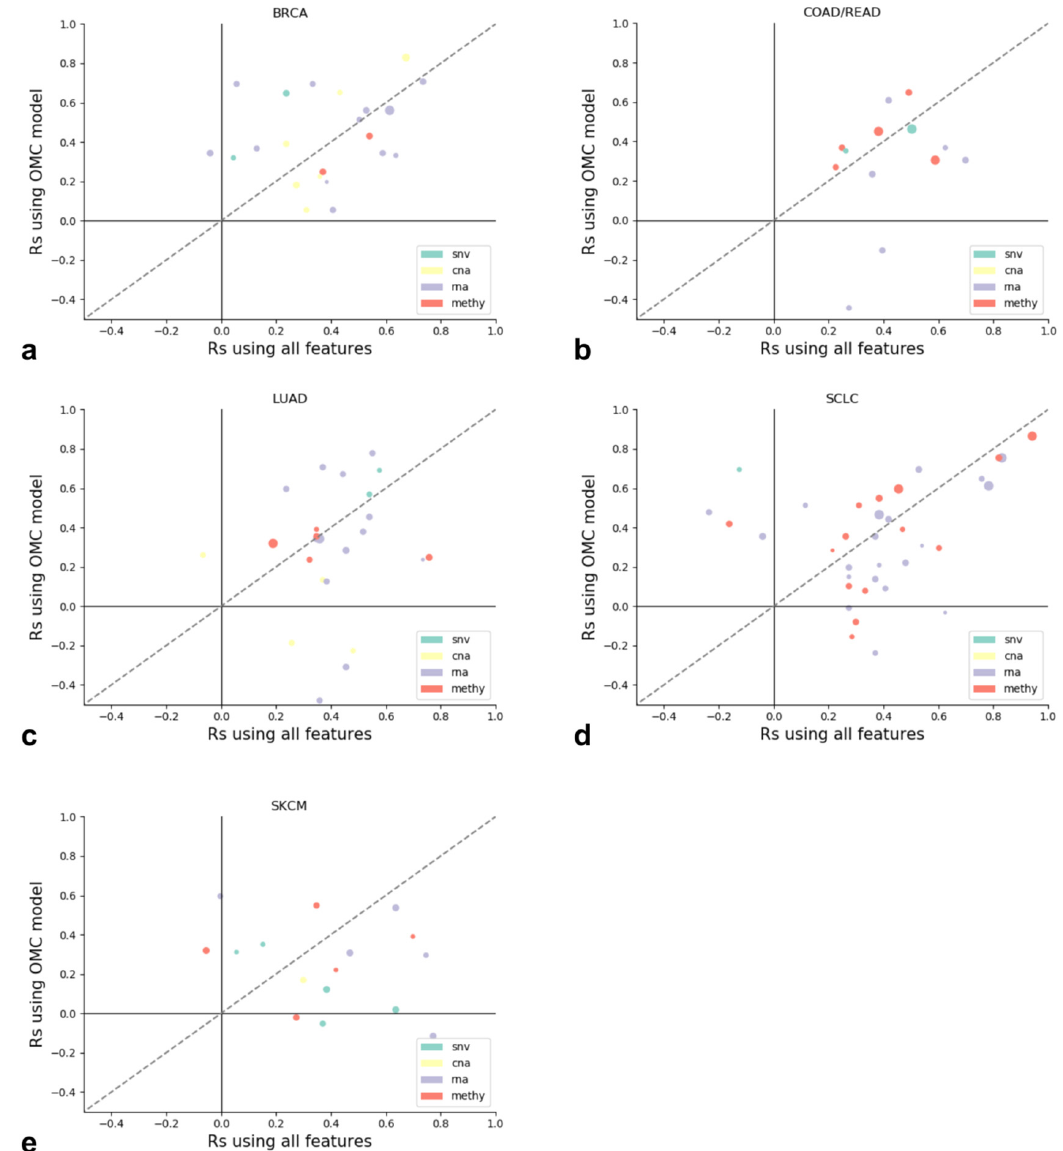
Figure 3. Test set Spearman’s correlations across all 118 cases with predictive models (i.e., R s in validation folds > 0.25 and R s in test set > 0.25). The case with the most predictive omics profile is shown as the node color, while the size of the dots represents the OMC. The dashed gray line represents a 1: 1 ratio between both. In each of the five cancer types ( a : BRCA, b : COAD / READ, c : LUAD, d : SCLC, e : SKCM), the results from both methods are remarkably di ff erent overall, despite using the same base learner (XGB) as well as the same set of training and test sets. This strong di ff erence is evidence of their complementarity.